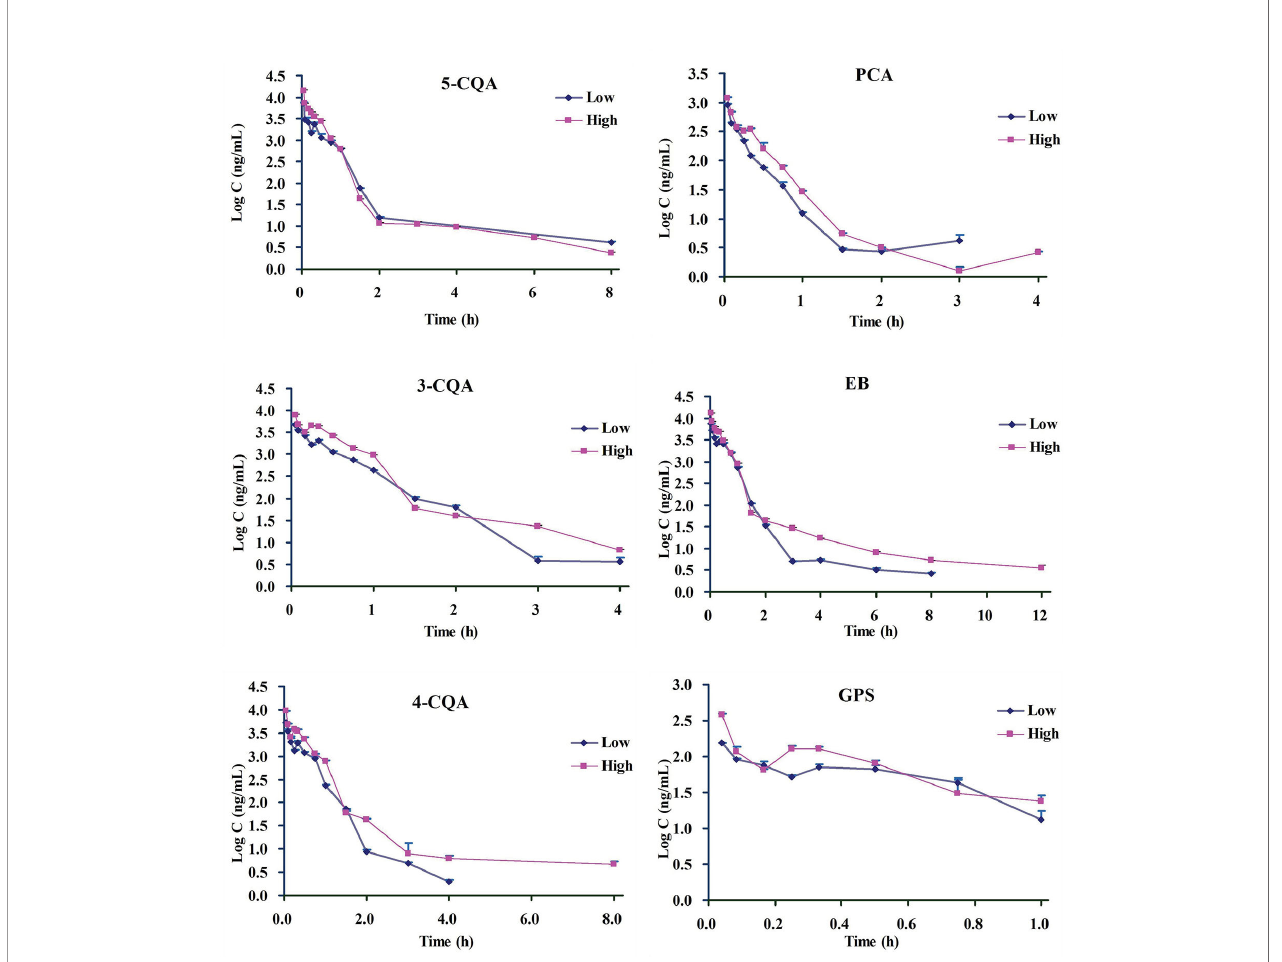
FIGURE 2 | The mean drug plasma concentration – time curves for the 6 ingredients after i.v. administration of Acanthopanax senticosus extract preparation (ASEP) (low and high dosages) (Mean ± SD, n